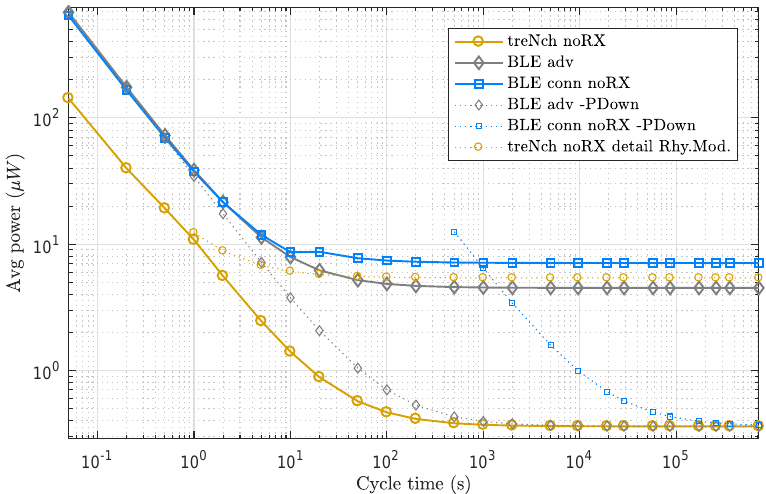
Figure 7. Use case of node with only transmission needs. Average power of a complete cycle over cycle time. Note logarithmic scale in both axes